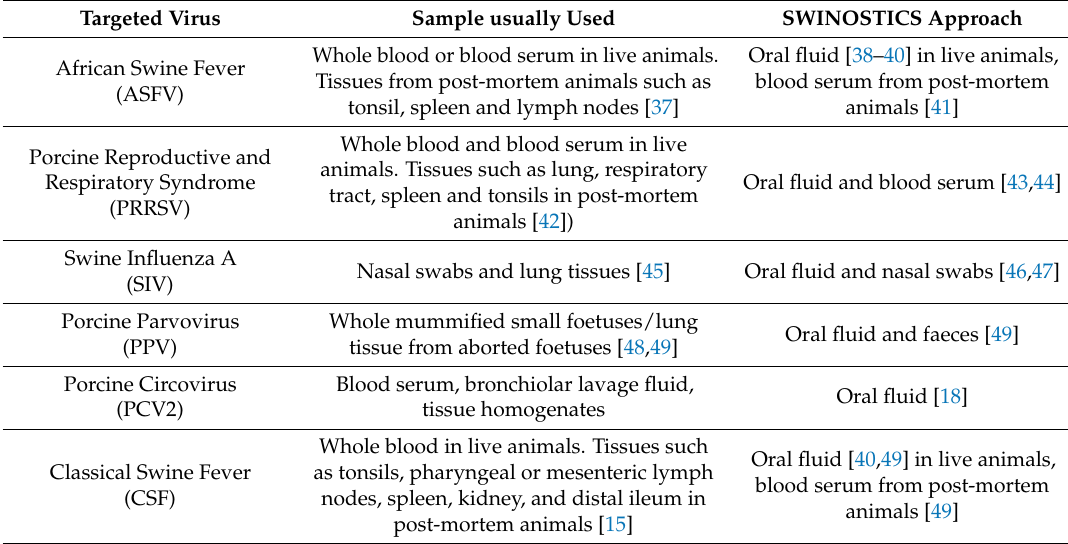
Table 1. List of emerging and endemic pathogens viruses in